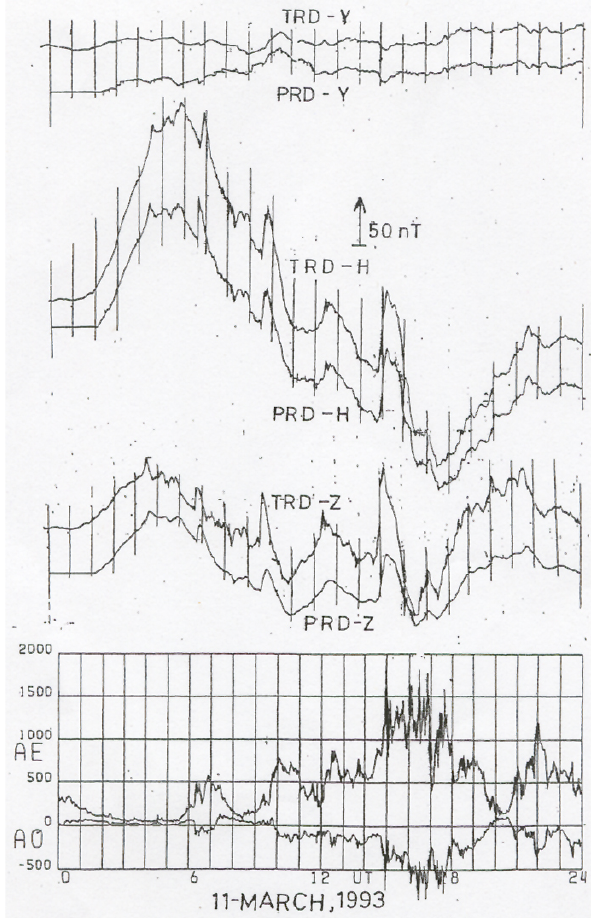
Fig. 9. Magnetograms at PRD and TRD on 11 March 1993 showing the effect of SSC on the H , Z and Y fields.